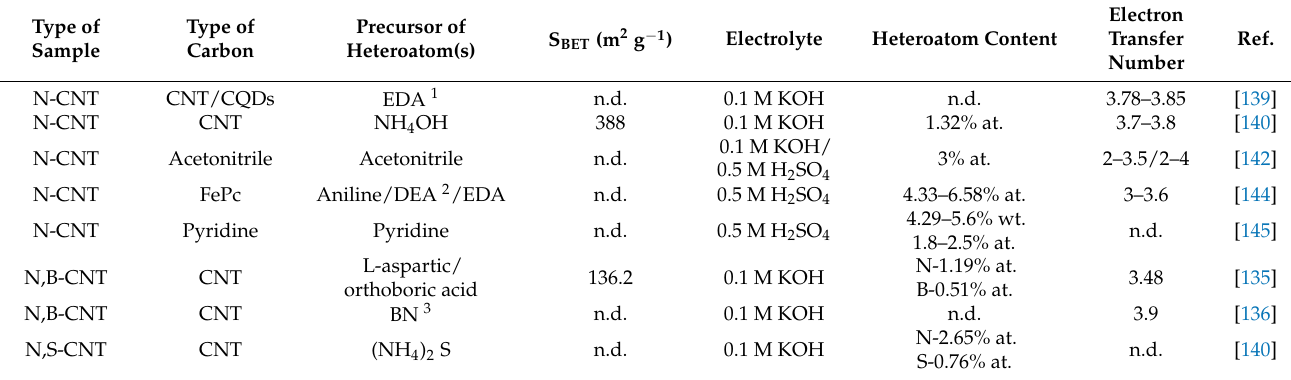
Table 5. Summary of nitrogen-doped carbon nanotubes synthesized via CVD and the hydrothermal method electrocatalyst for